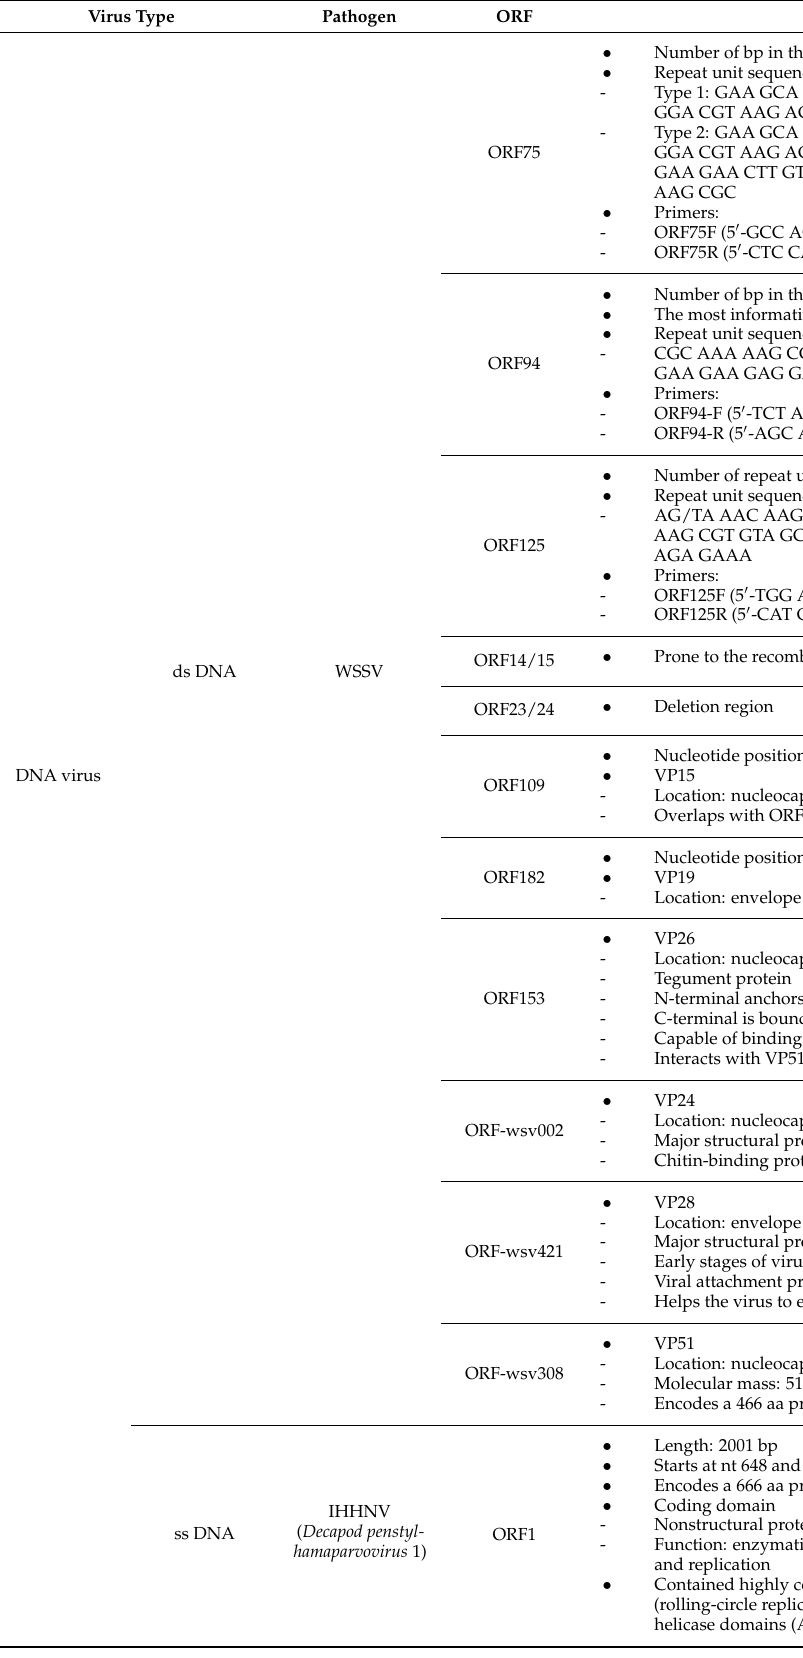
Table 2. Summary of the DNA and RNA viral diseases ORF